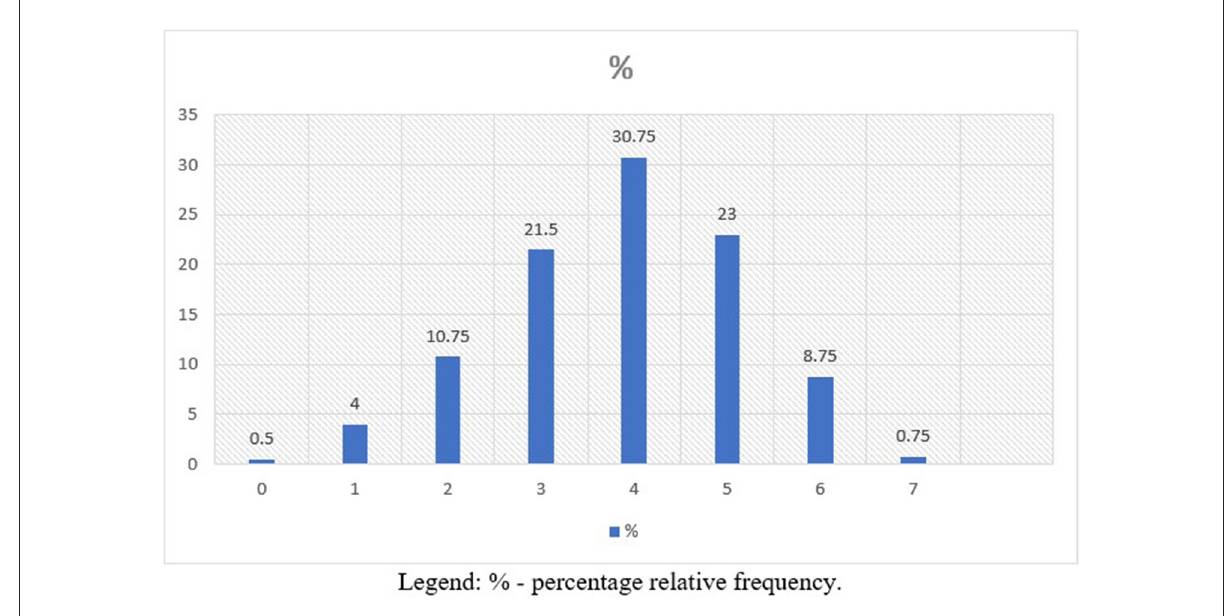
FIGURE2 Number of ideal CVH metrics in the population ( n =